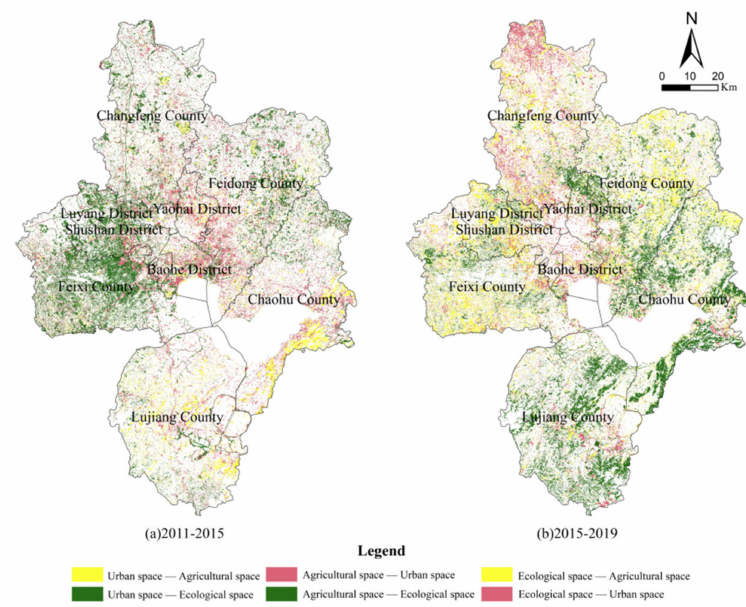
Figure 4. Spatial evolution of UAE pattern. Table 3. Evaluation index system of PLE function under carbon